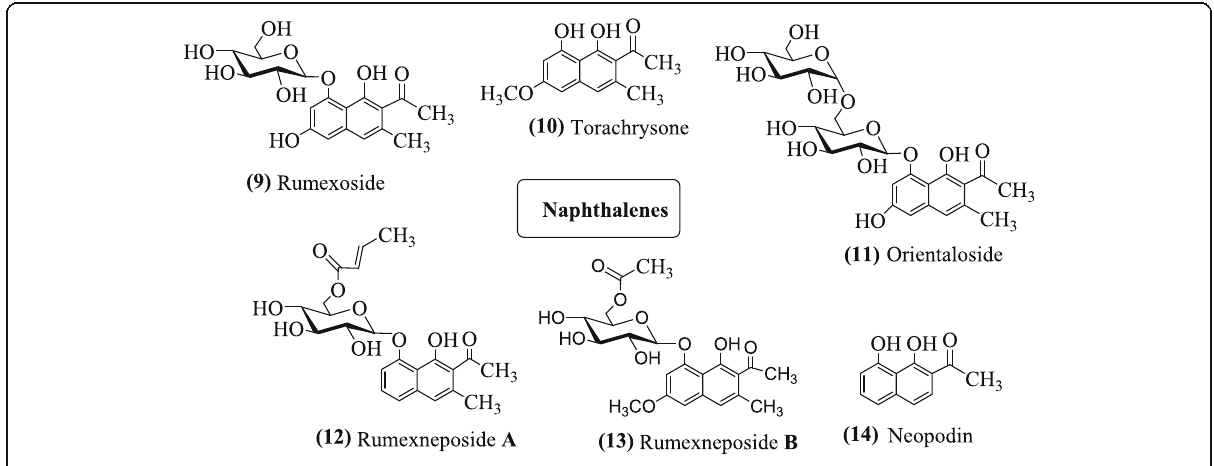
Fig. 3 Isolated naphthalene compounds from the root extracts of R.